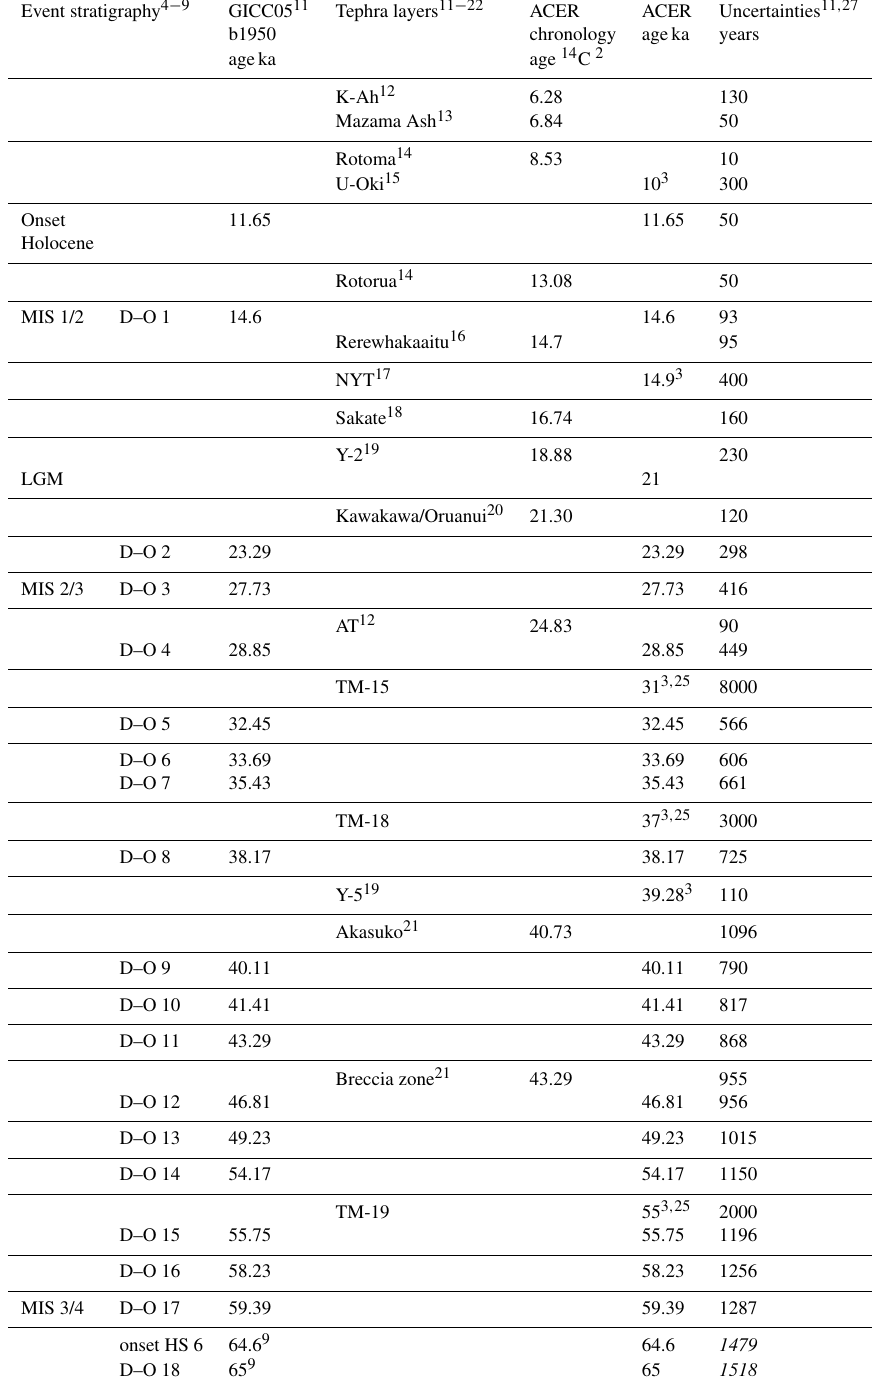
Table 1. Harmonized control points used for age models when radiometric ages ( 14 C, OSL, 40 Ar / 39 Ar, 234 U / 230 Th) were not